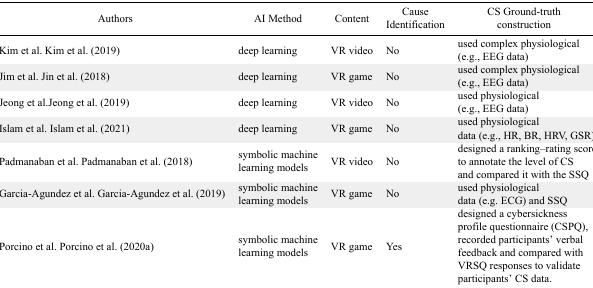
Table 3. A summary of related works aimed in mitigate CS prob­ lems using symbolic and deep learning